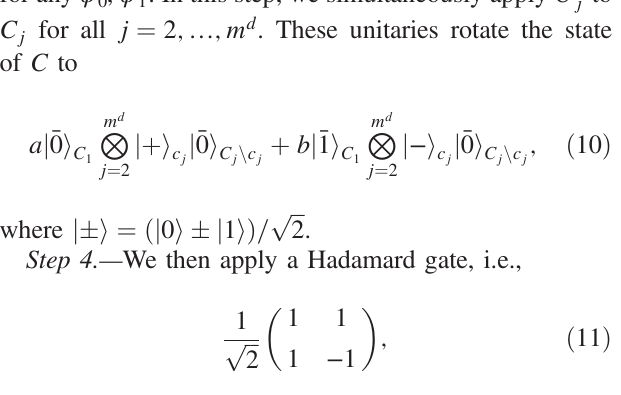
FIG. 1. A demonstration of our protocol for encoding a qubit into a GHZ-like state in a one-dimensional system C . Initially, the unknown coefficients a , b are encoded in one qubit (red circle) while the other qubits are each initialized in state j 0 i . The first step of the protocol assumes the ability to encode information into GHZ-like states in subsystems C 1 ; … ; C 4 using, for example, nearest-neighbor interactions. In step 2, we apply a generalized controlled-phase gate [Eq. (6)] between the subsystems to “ merge ” the GHZ-like states into an entangled state between all sites. The last three steps rotate this entangled state into the desired GHZ-like state by concentrating the entanglement in each subsystem onto one qubit, applying single-qubit rotations, and redistributing the entanglement to the rest of the system. Repeatedly feeding the resulting GHZ-like state back into step 2 of the protocol yields larger and larger GHZ-like